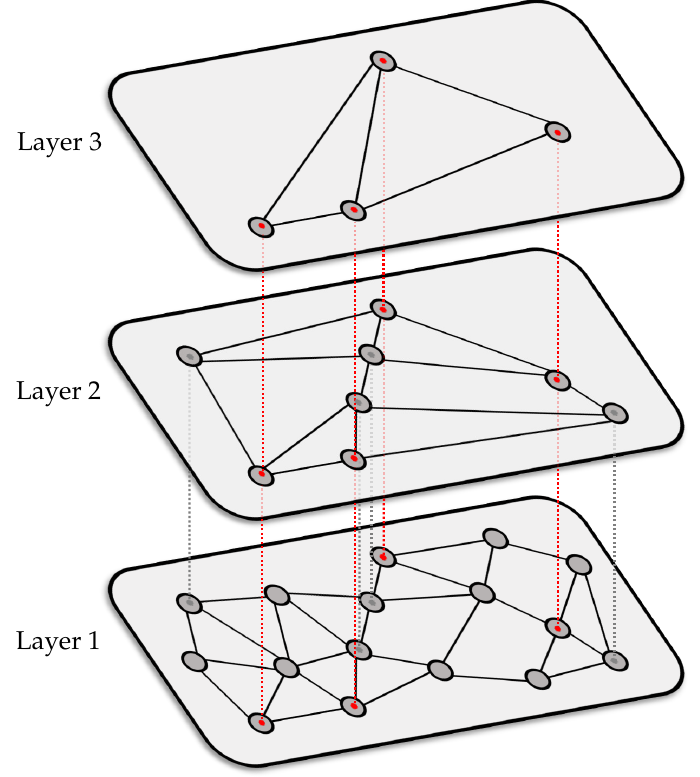
Figure 4. Illustration of HNSW